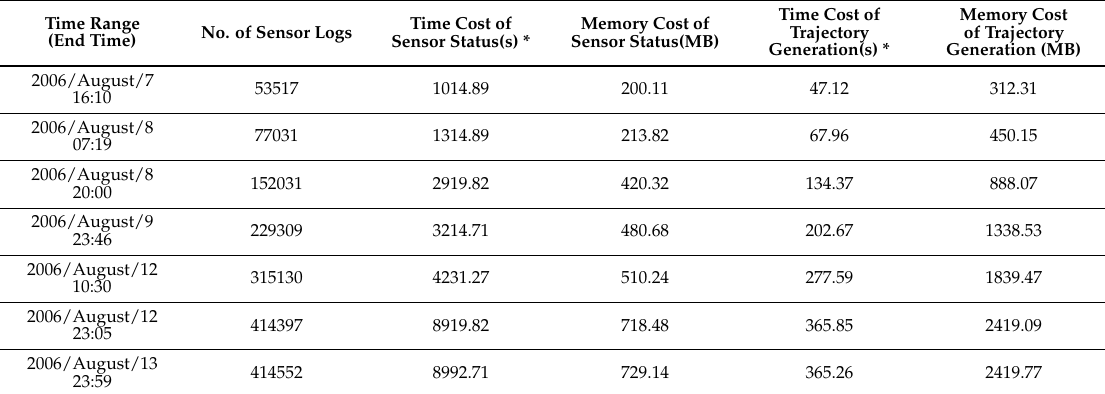
Table 1. The computation performance evaluation (Start from 2006/August/7